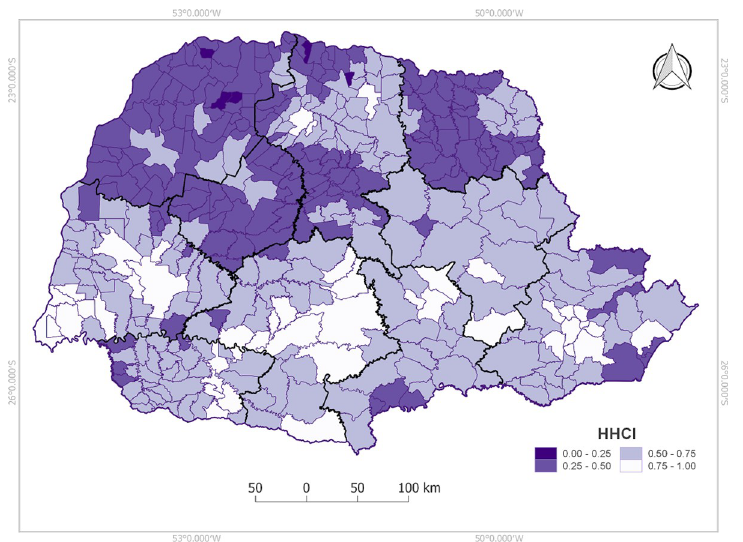
Fig 5. Distribution of the generated municipalities index. 1 lower risk and 0 higher